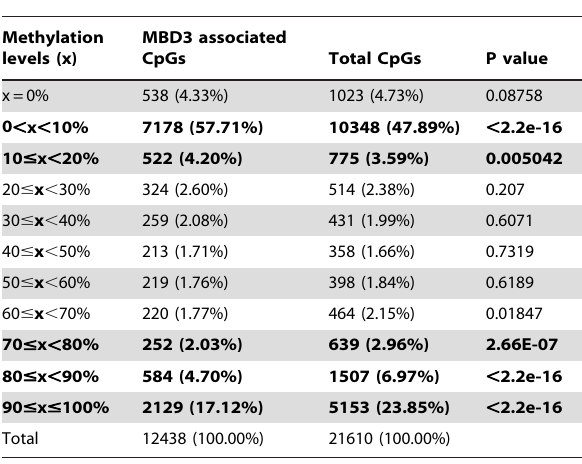
Table 1. Methylation level of CpG island with an MBD3 peak that fall into within the indicated levels of DNA methylation as determined by